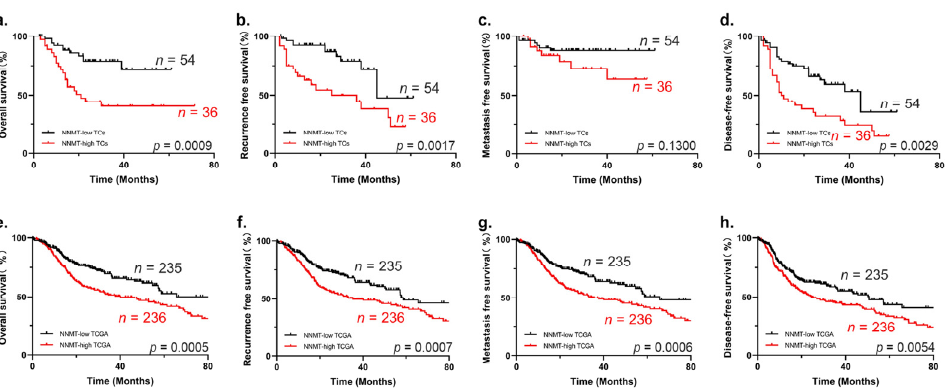
Figure 4. Kaplan–Meier survival curves for OS, RFS, MFS and DFS of OSCC patients. ( a – d ) High expression of NNMT has poor OS, RFS and DFS of patients according to our cohort, n = 90. ( e – h ) High expression of NNMT also has poor OS, RFS, MFS and DFS of patients using TCGA database. OS, overall survival; RFS, recurrence-free survival; MFS, metastasis-free survival; DFS, disease-free survival.